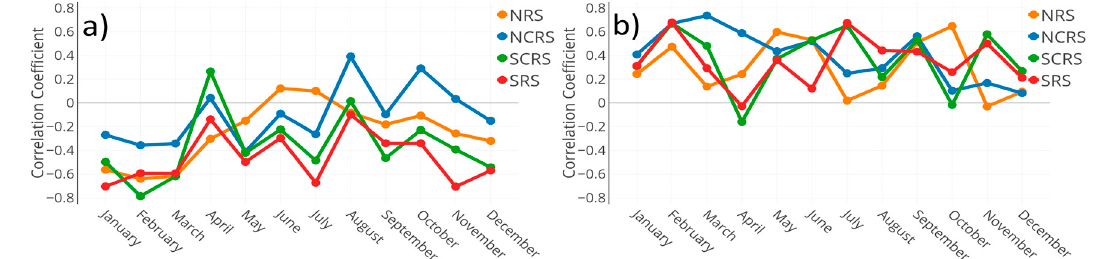
Figure 6. Time series plot of monthly anomaly correlation coefficients for the four regions of the Red Sea; ( a ) SST/Chl- a ; ( b ) DAOD (MERRA-2 Dust Scattering AOT in 550 nm)/Chl- a .